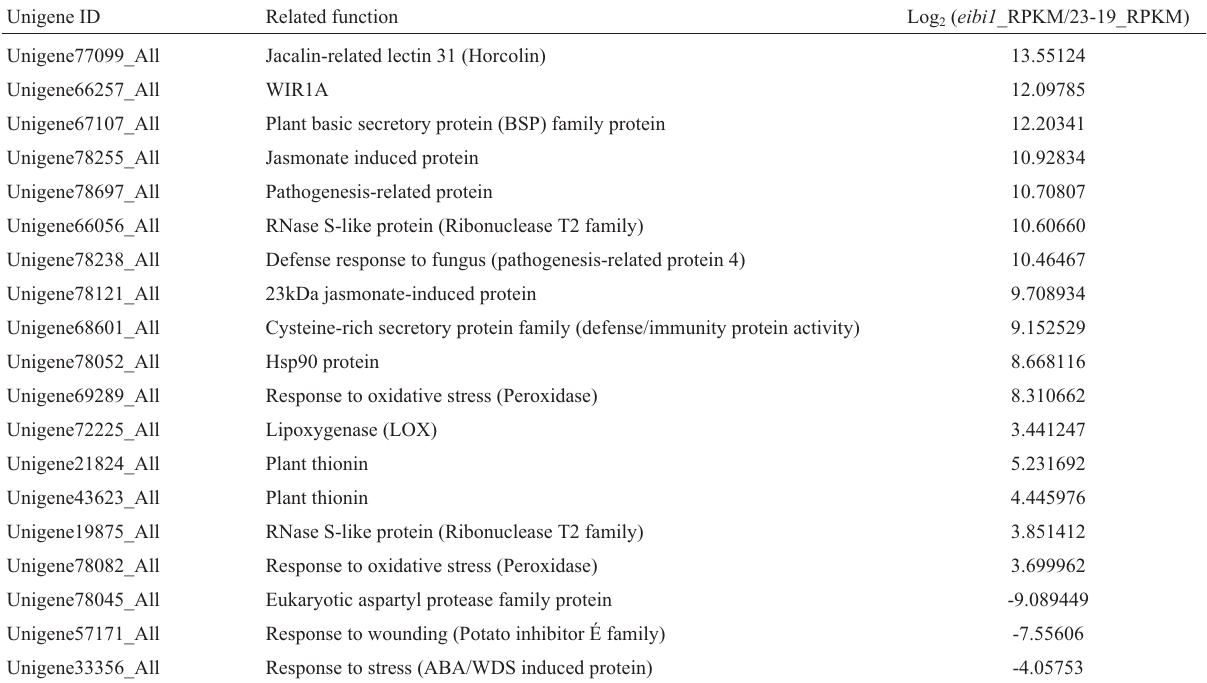
Table 3 - Relative expression of defense-related